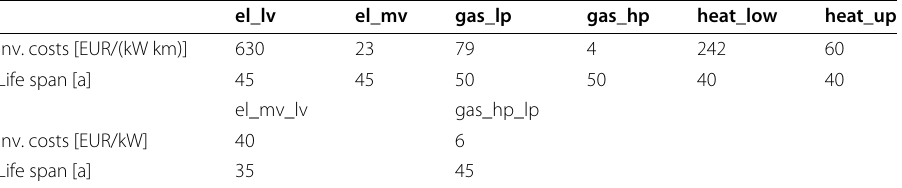
Table 2 Investment costs and life span for electric, gas, and heat edges in lower and upper grid level as well as transformers (electric) and pressure regulators (gas) el_lv el_mv gas_lp gas_hp heat_low heat_up Inv. costs [EUR/(kW